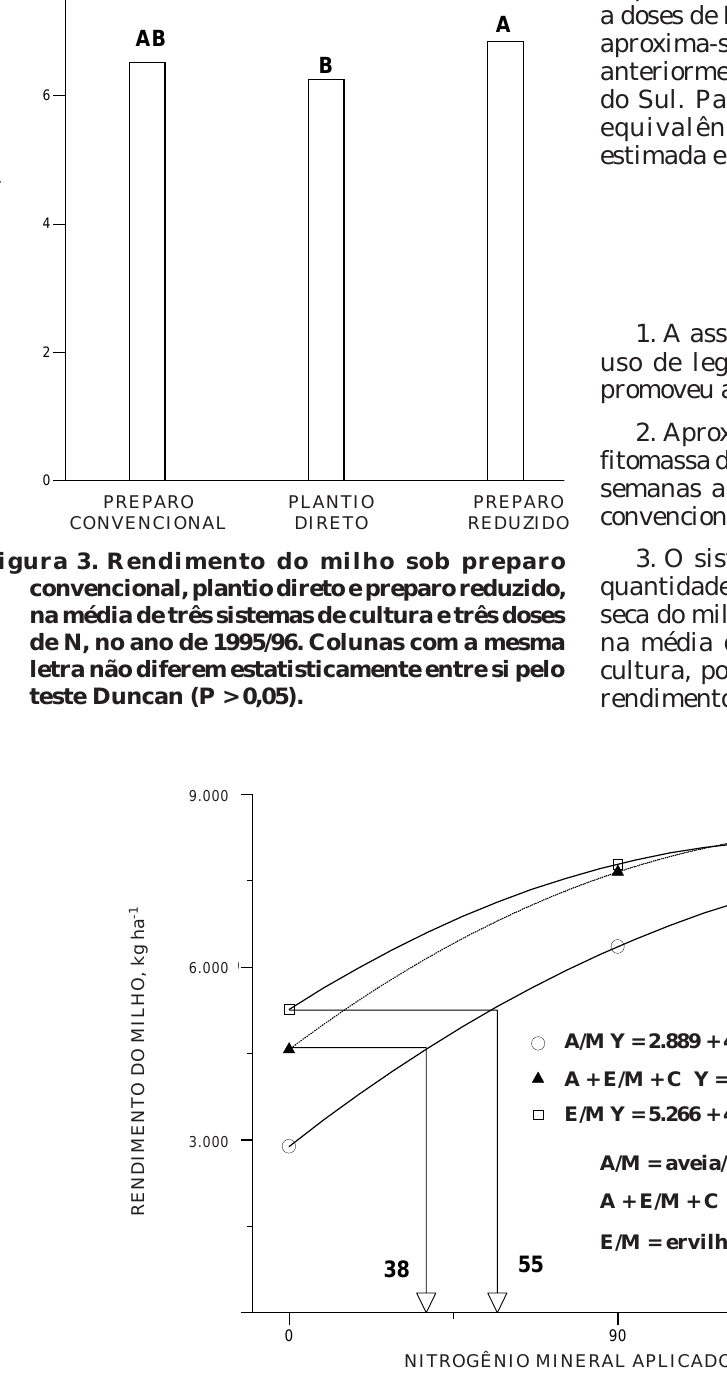
Figura 4. Curva de resposta à adubação nitrogenada de três sistemas de culturas, na média de três sistemas de